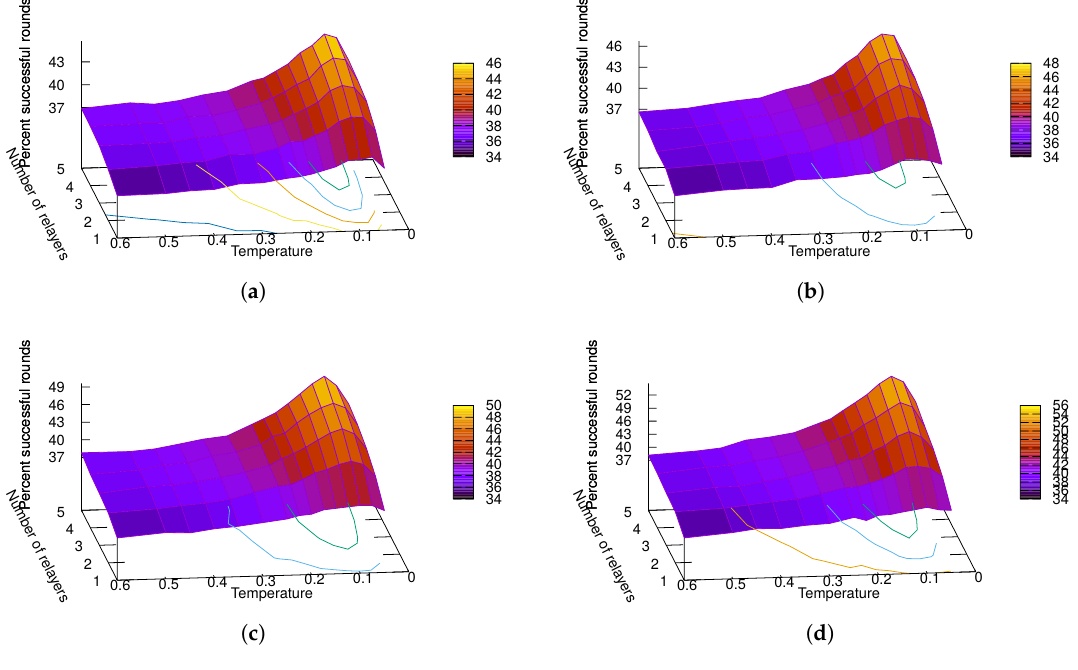
Figure 2. Average fraction of successful rounds for learning(PAR)- τ schemes for varying τ and varying numbers of relayers over two-state channels with different probabilities p to stay in the same state. ( a ) p = 0.9; ( b ) p = 0.99; ( c ) p = 0.999; ( d ) p =